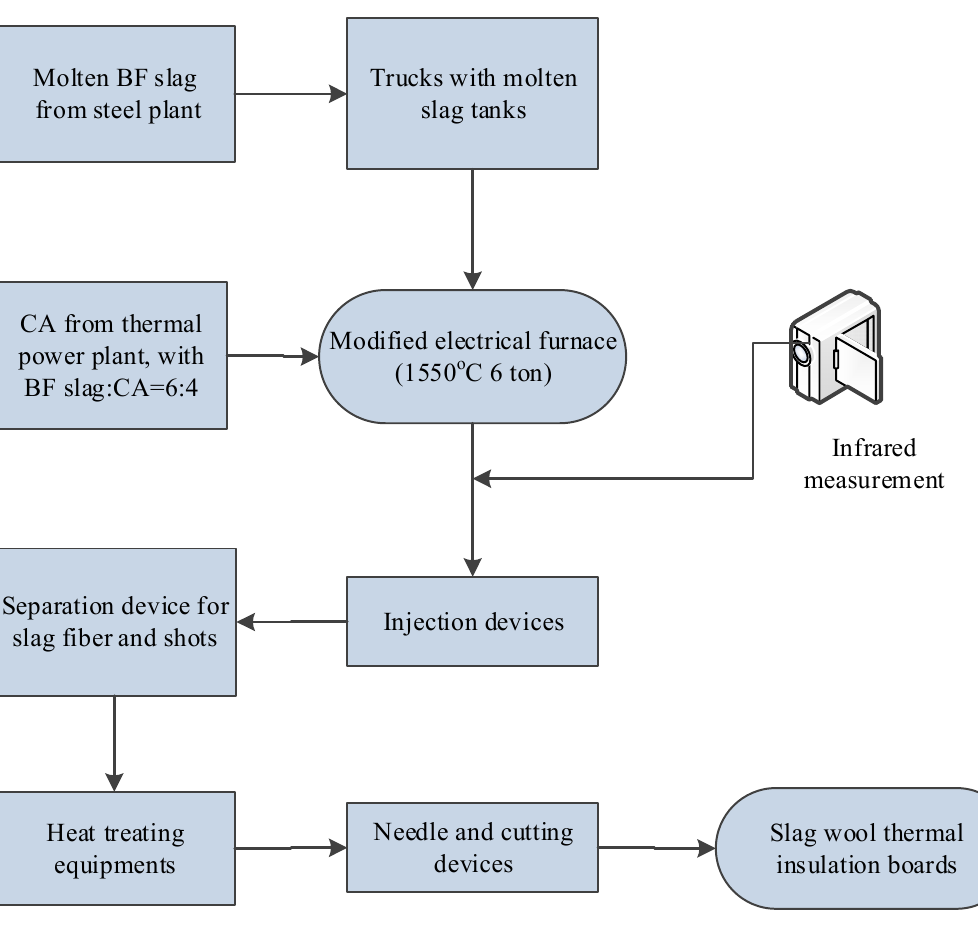
Figure 11. Process flow diagram for slag wool insulation